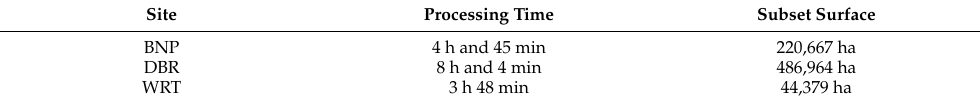
Table 7. Processing time for each study